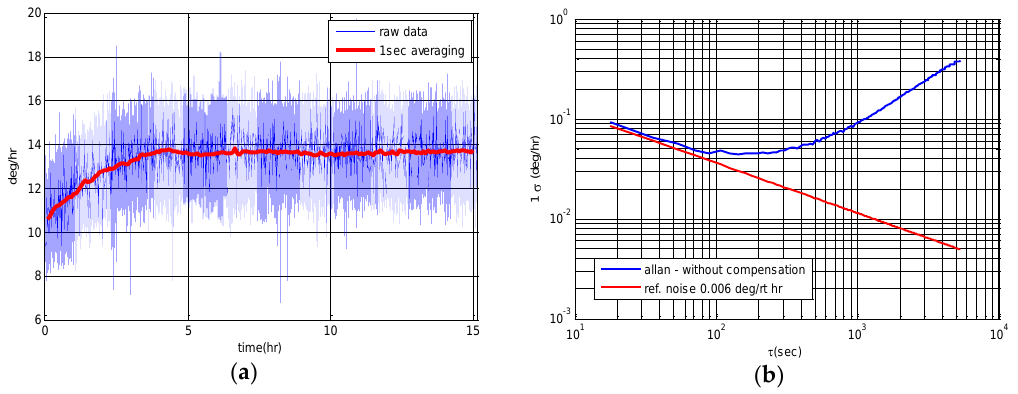
Figure 17. Test results to measure the bias instability and ARW: ( a ) Gyro rate output for 15 h in the sound absorbing chamber; ( b ) Allan variance analysis result for the estimate of bias instability and ARW.